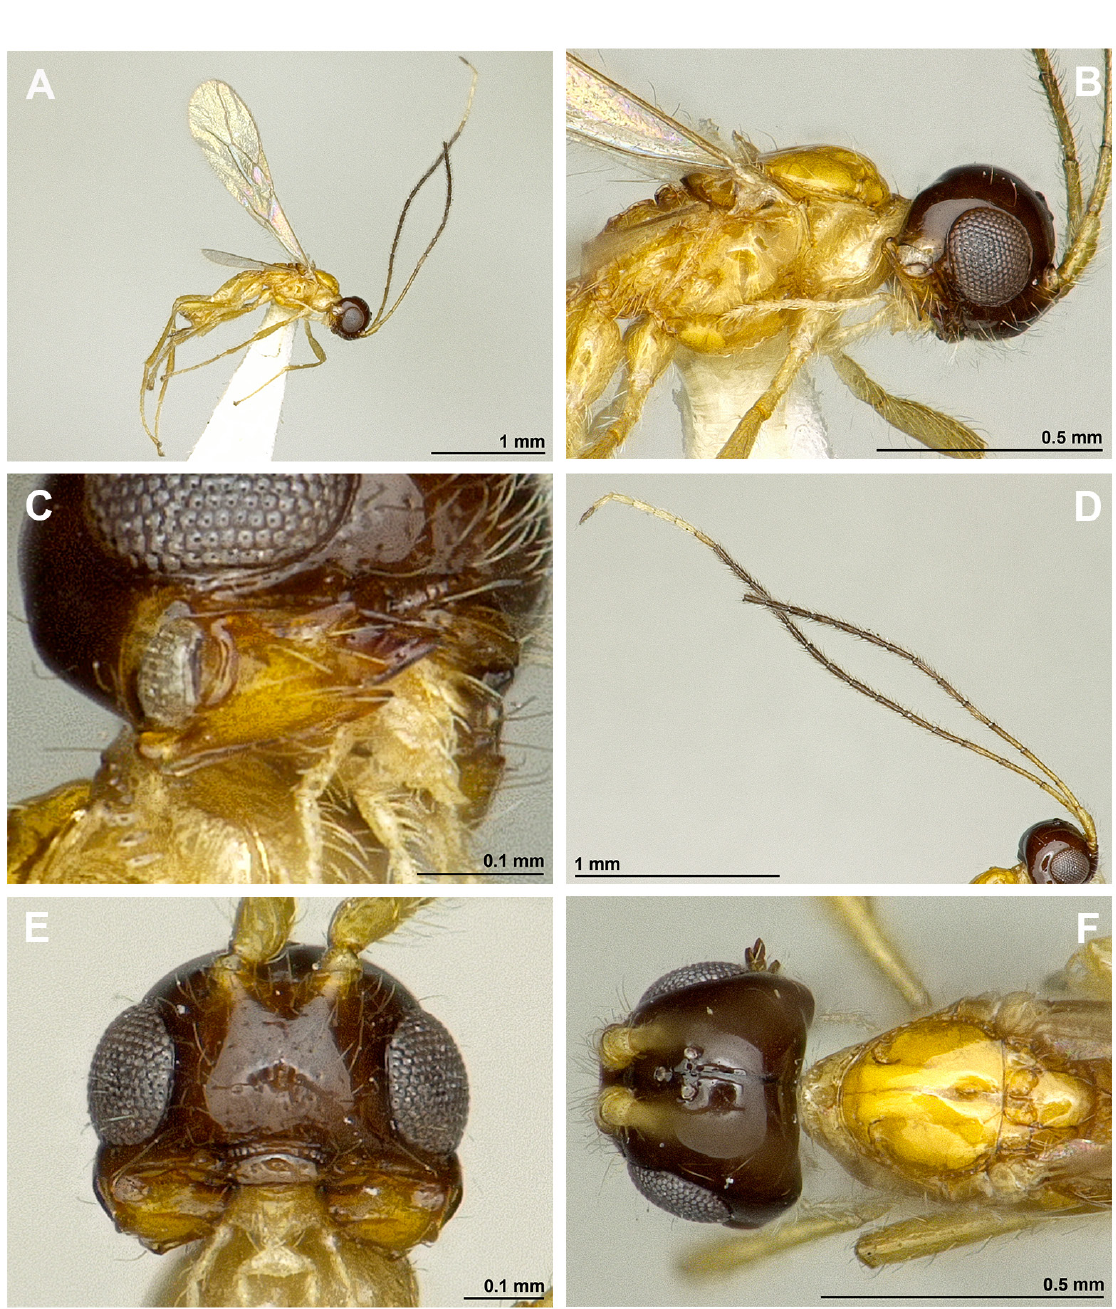
Fig. 78. Asobara zimbabwana Peris-Felipo, sp. nov., ♀, holotype (BMNH). A . Habitus, lateral view. B . Head and mesosoma, lateral view. C . Mandible. D . Antenna. E . Head, front view. F . Head and mesoscutum, dorsal